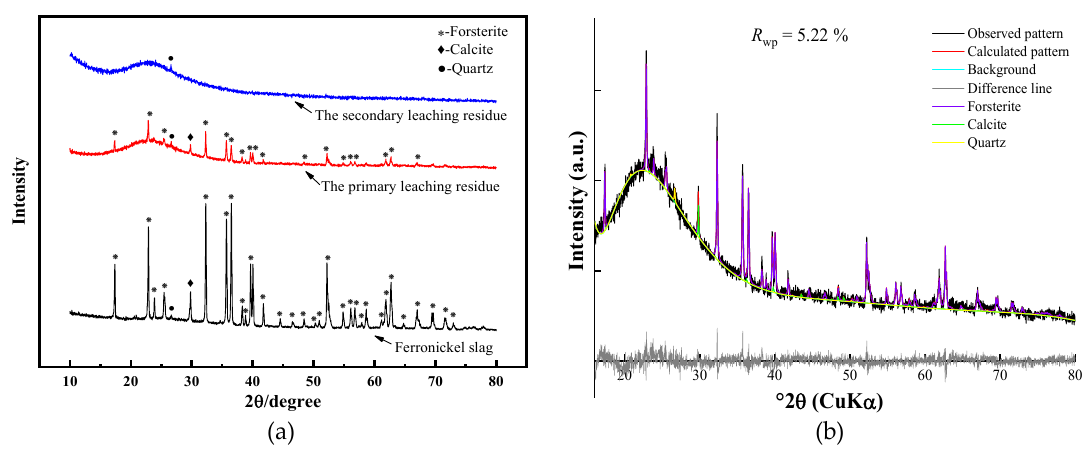
Figure 5. ( a ) XRD comparison of the FNS and acid leaching residues; ( b ) Rietveld XRD diagram of the primary leaching residue.